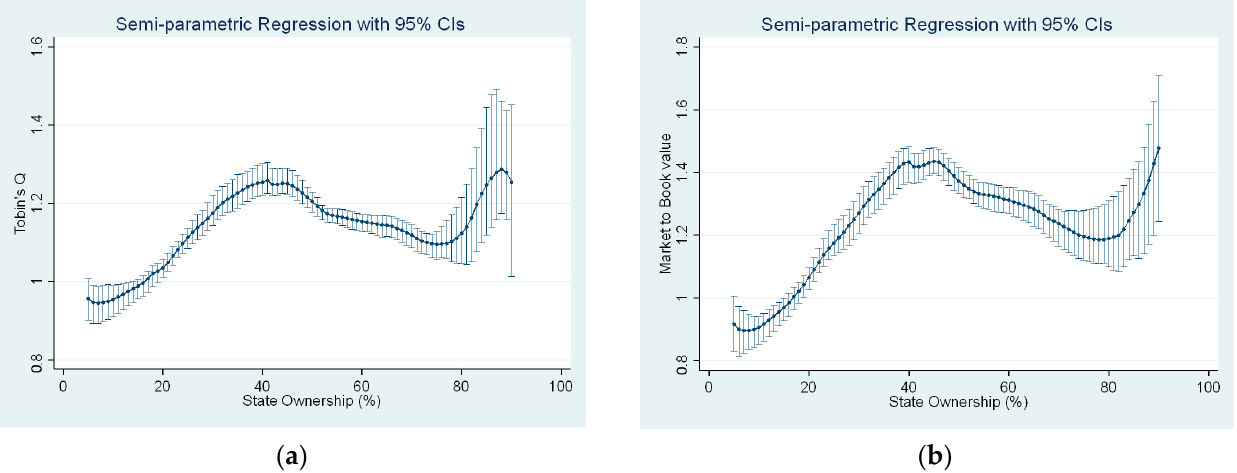
Figure 2. Semiparametric estimates of firm’s Tobin’s Q ( a ) and market to book value ratio ( b ) against state ownership (%). This figure presents the marginal effect of state ownership on partially privatized firm’s Tobin’s Q and market to book value ratio. The continuous lines correspond to the estimates, whereas the capped spikes correspond to the 95% confidence intervals.